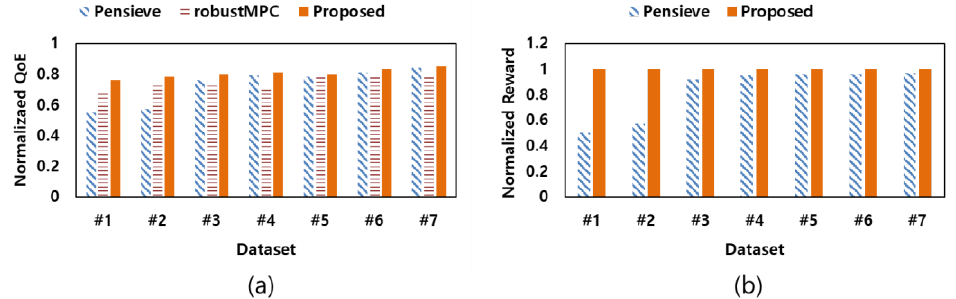
Figure 5. Normalized QoE and reward according to the dataset, ( a ) normalized QoE, ( b ) normalized reward.